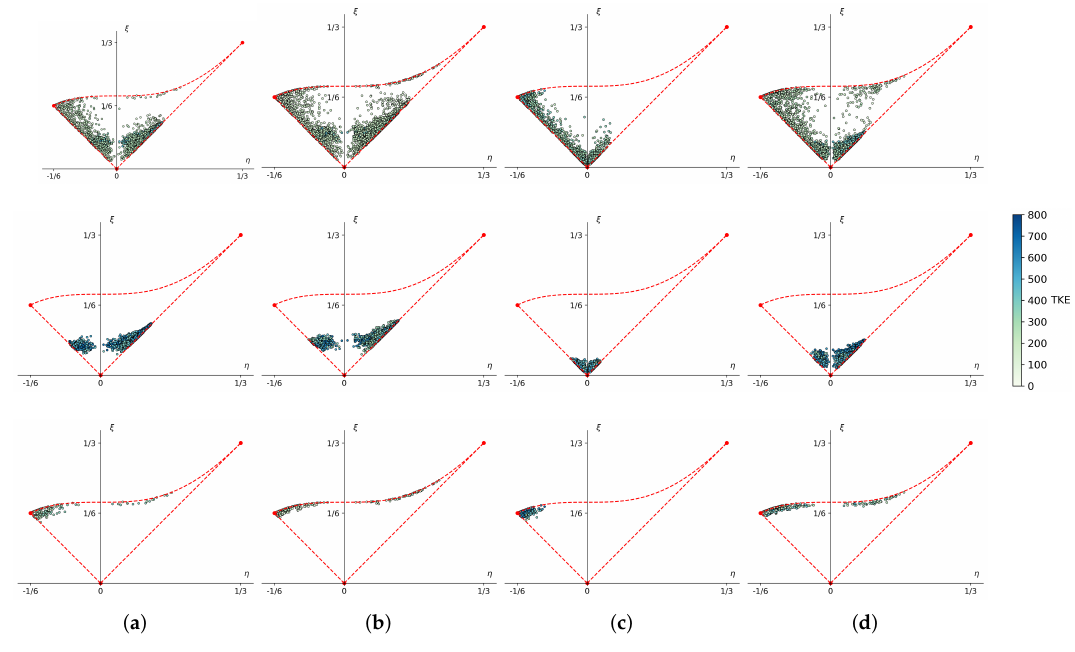
Figure 18. Turbulence triangle at plane 40. ( a ) F99. ( b ) F65. ( c ) T0. ( d ) T2. Downstream of the vane, i.e., at plane 41, for the SPOD cases, observations are similar (Table 5). The cases using a large part of the energy in the reconstructions have values very close to the reference. Likewise, the cases without turbulence injection have very low fluctuation values. Note that for the cases T0 and T2 , although the levels of TKE in plane 40 are identical to the reference, levels at plane 41 are significantly lower than the reference. As for plane 40, the turbulence triangles of F99 , F65 , T0 , and T2 are shown in Figure 19. For F99 and F65 , from the values given in Table 5, one could think that the turbulence had become isotropic after the vane. However, the turbulence triangles for the nodes located in the channel center show that it is not the case. The nodes remain far from the lower corner of the triangle which corresponds to isotropic turbulence. For cases T0 and T2 , the turbulence properties are close, despite the lower level of turbulence